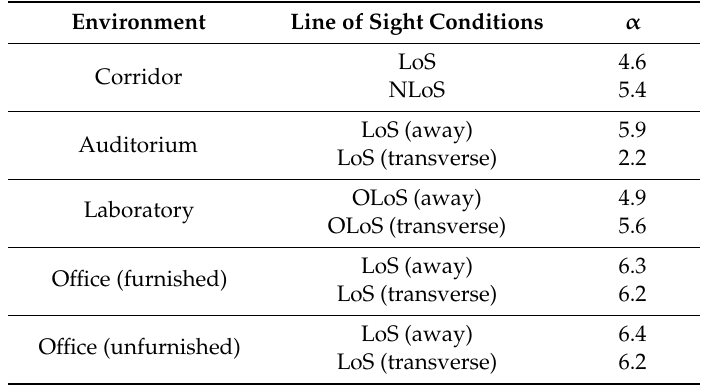
Figure 9. Coherence bandwidth at correlation level 0.9 vs. RMS delay spread in the auditorium with the receiver moving away from the transmitter. Table 4. Factor relating coherence bandwidth at correlation level 0.9 and RMS delay spread.